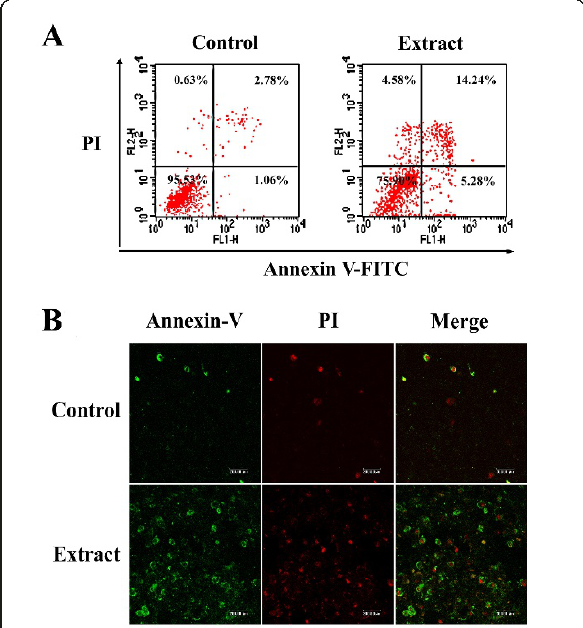
Figure 3 Apoptotic percentage distribution and observation by Annexin V/PI assay . PC-3M-1E8 cells were treated with 10 μ g/ml TC extract for 48 h and stained with annexin V-FITC antibody (green staining) and propidium iodide (red staining) and analysed by flow cytometry (A) and observed using a confocal microscopy (B). Scale line = 200 μ